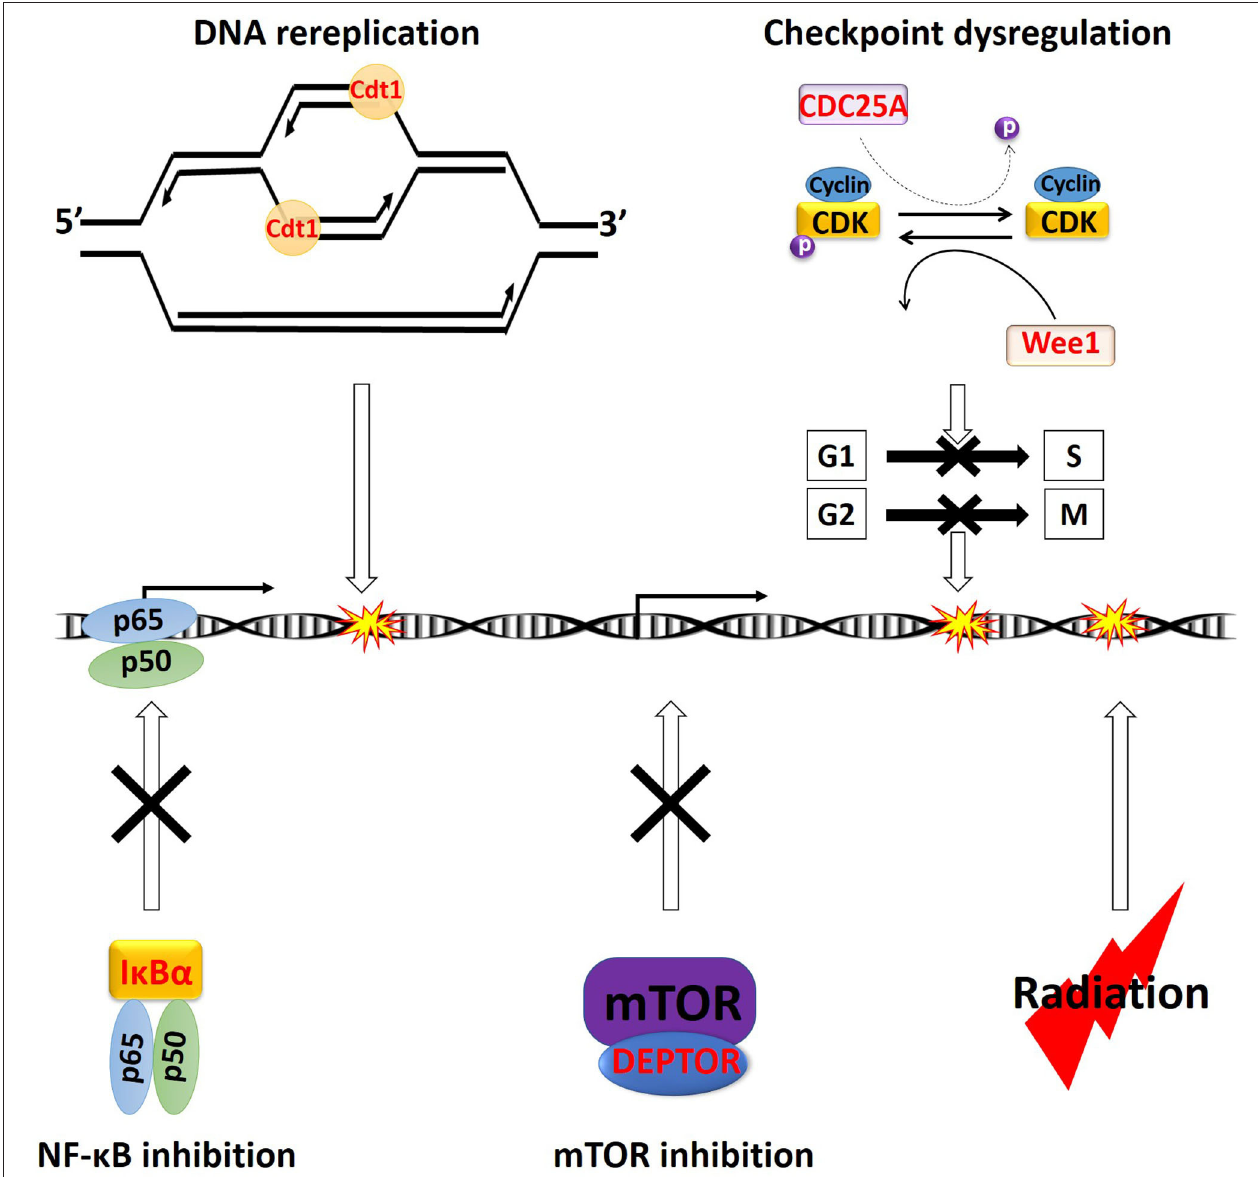
FIGURE 2 | Overview of the major cytotoxic mechanism of NEDDylation inhibition. All the characters in “Red” color are CRL substrates. Accumulation of Cdt1 can trigger DNA rereplication, resulting in DNA damages. Stabilization of CDC25A can potentially cause dysregulation of both early (G1 phase to S phase) and late (G2 phase to M phase) cell cycle checkpoints (dash arrow). Meanwhile, the accumulation of Wee1, p21, and p27 will trigger cell cycle arrest at the G1 or G2 phase. Stabilization of I κ B α will lead to sequestration NF- κ B p65 and p50 heterodimer in the cytosol, leading to inhibition of its transcriptional activities. Stabilization